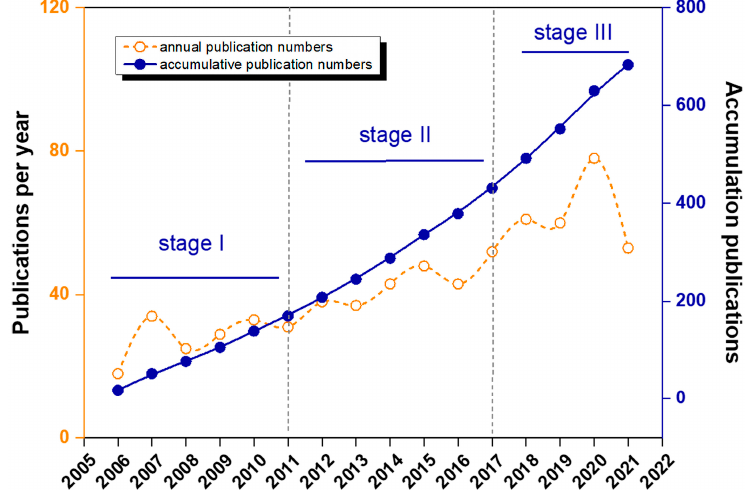
Figure 2. Annual and cumulative distribution of publications trend map.